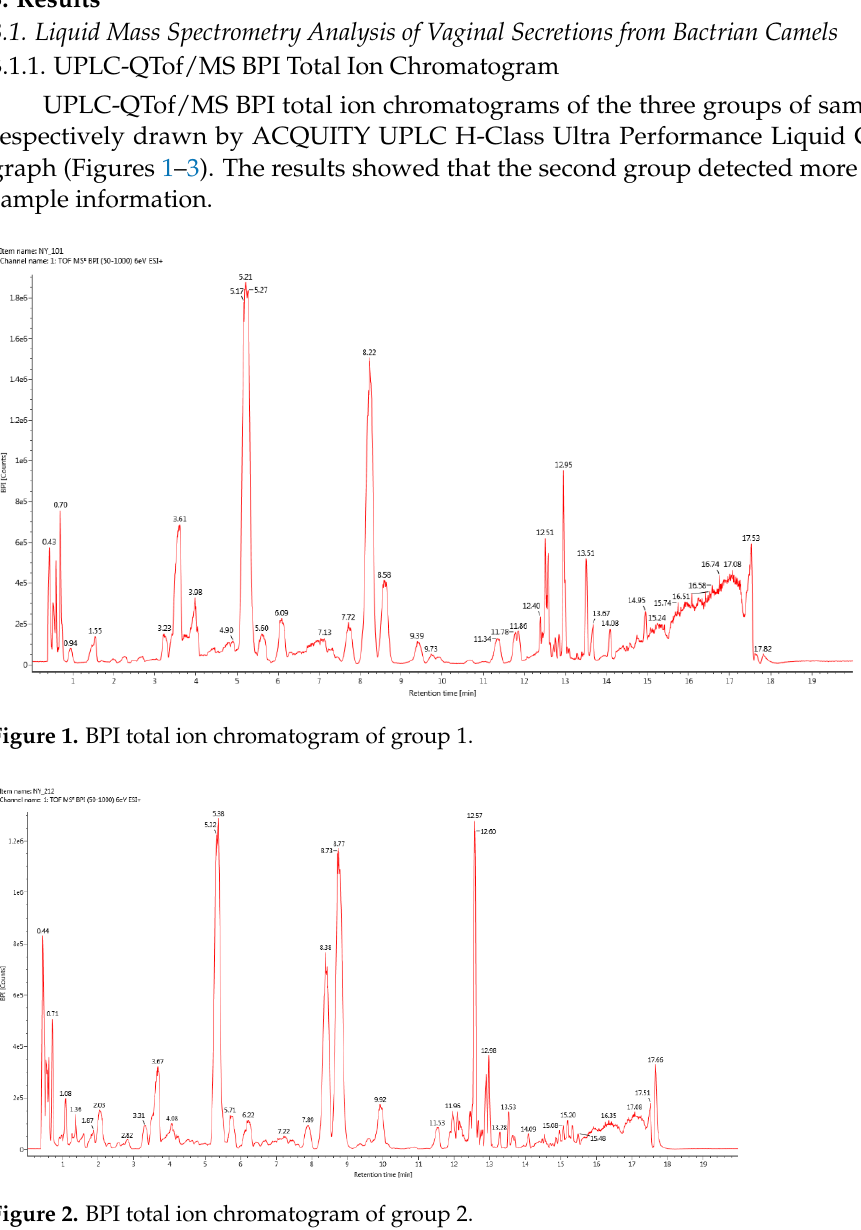
Figure 3. BPI total ion chromatogram of group 3. 3.1.2. Structure Determination of the Main Components The raw data were collected by ACQUITY UPLC H-Class Ultra Performance Liquid Chromatograph; the UNIFI was used for the qualitative analysis. Setting appropriate ac- quisition parameters and using the overall workflow of UNIFI software were combined with a self-built database of common vaginal compounds for data processing and struc- ture matching. A total of 140 vaginal compounds of Bactrian camels were identified by the software, among which, 9 compounds with a high matching degree were identified (Figure 4). Figure 4. Structure determination of the major compounds in positive ion mode for Bactrian camels’ vaginal secretion samples.